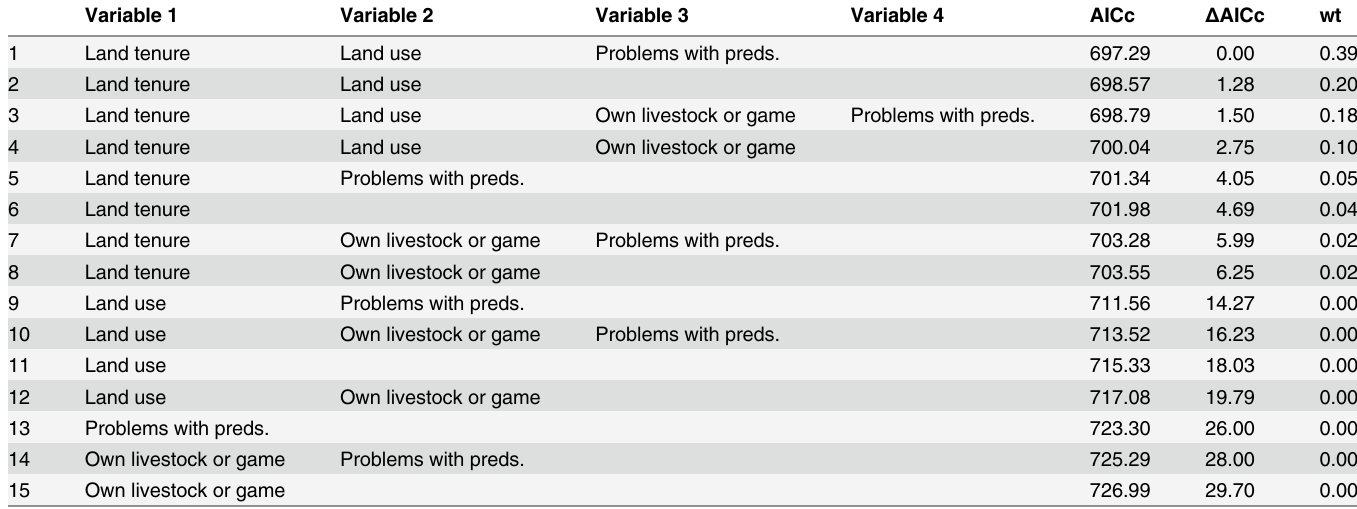
Table 4. The Akaike information criterion (AICc) values for regression models investigating the effects of property variables on the threat index of